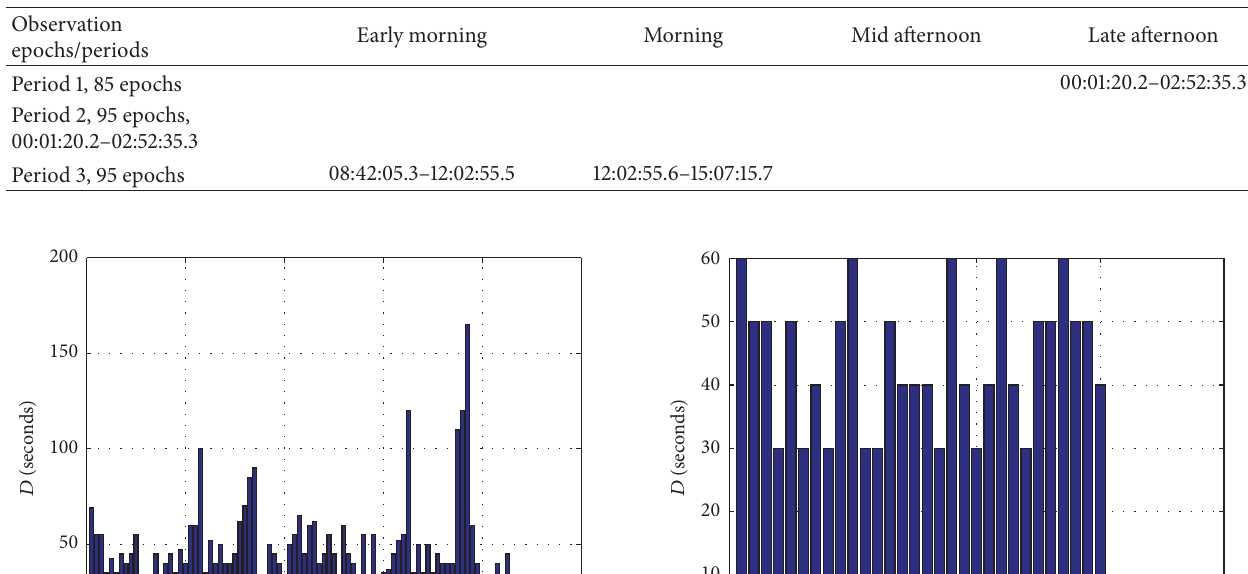
Table 2: Observation epochs used to investigate the back-to-back connection duration.